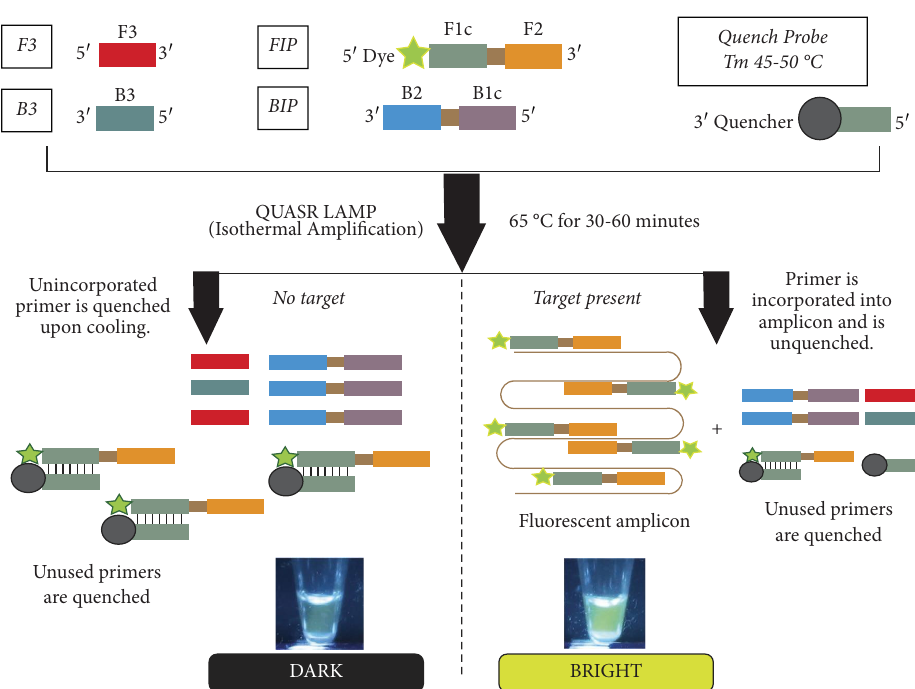
Figure 3: Principle of quenching of unincorporated amplifcation signal reporters (QUASR) detection in LAMP. One of the loop primers (LF or LB) or inner primers (FIP or BIP) is labeled with a dye. Te reaction mixture also contains a short probe, labeled with a dark quencher at the 3 ′ end and complementary to 7–13 bases at the 5 ′ end of the dye-labeled primer. Te quench probe is present in slight excess relative to the labeled primer and has Tm > 10 ° C below the temperature of the LAMP reaction, such that it remains dissociated during the am- plifcation. After incubation, the reaction is cooled to ambient temperature, resulting in the dark quenching of fuorescent primers (negative reactions) or highly fuorescent amplicons (positive reactions) [16]. Adapted from More with Less: Novel Approaches to LAMP Assay Design for Better Performance with Fewer Resources by R. Meagher,